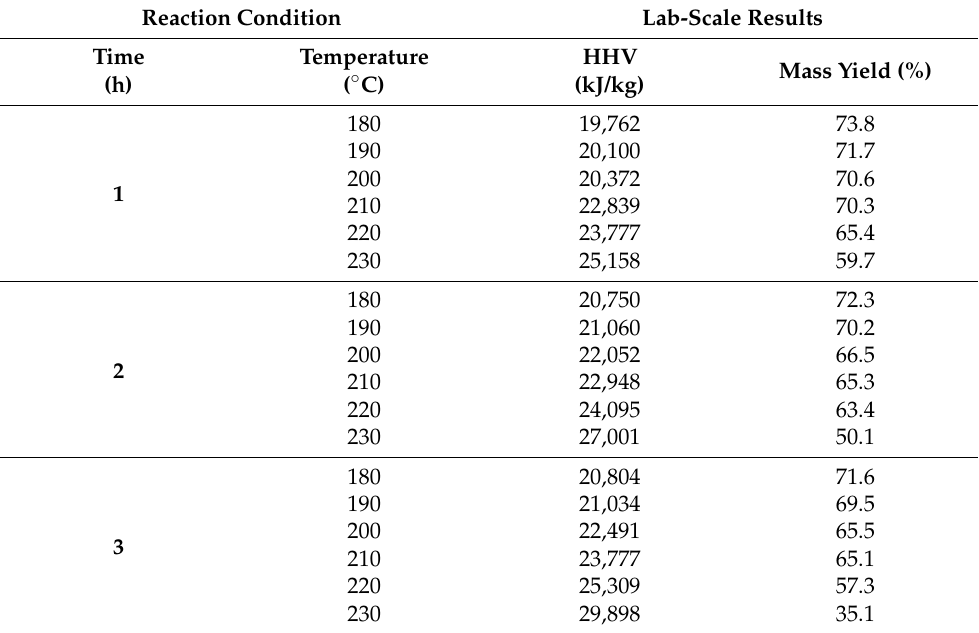
Table 2. Comparison of calorific value and mass yield after HTC of sawdust. Reaction Condition Lab-Scale